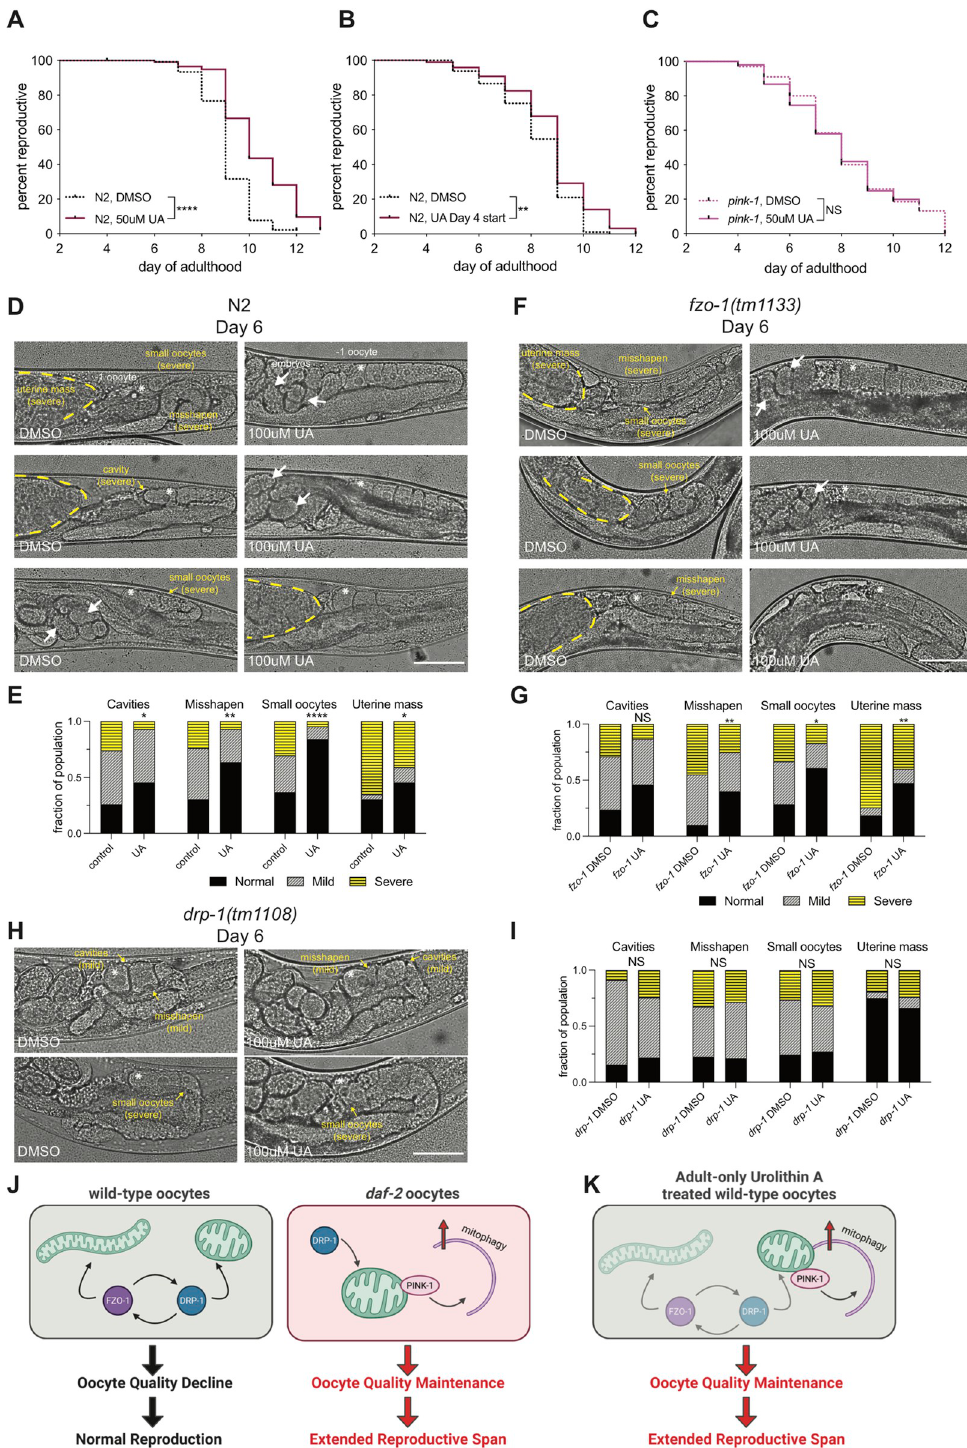
Fig 5. Urolithin A treatment slows reproductive decline in wild type. (A) Reproductive span of N2 control 0.3% DMSO (n = 100) and N2 50 μ M UA, 0.3% DMSO (n = 100). Treatment started on Day 1 of adulthood. (B) Reproductive span of N2 hermaphrodites with Urolithin A treatment starting at Day 4 of adulthood is improved. Both control (n = 100) and experimental (n = 100) groups began 0.3% DMSO at Day 1 and UA treatment began at Day 4 in the experimental group. p = 0.0062 (C) Reproductive span of pink-1(tm1779) is unchanged with UA treatment. Control 0.3% DMSO (n = 100)